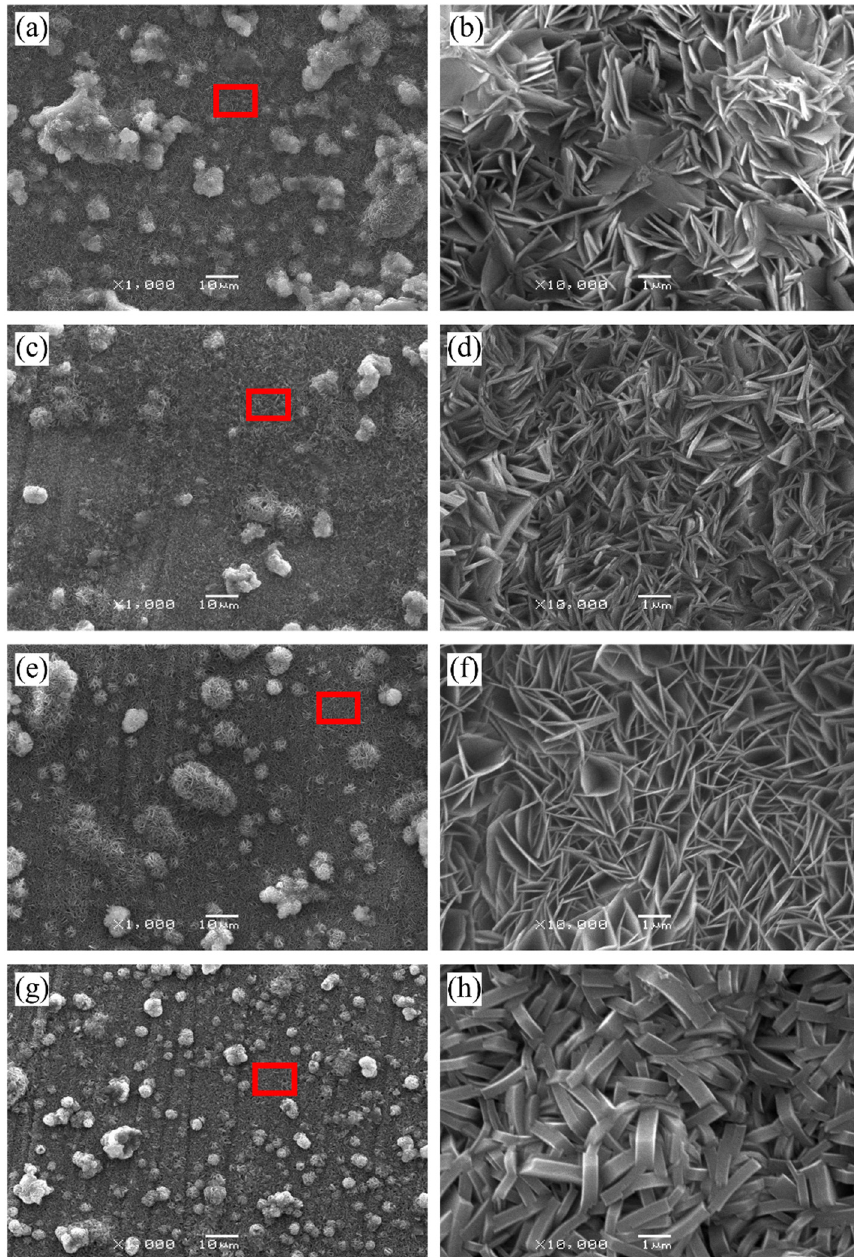
Figure 3. SEM images of different samples: ( a , b ) Mg(OH) 2 , ( c , d ) 6 h, ( e , f ) 12 h, ( g , h ) 24 h. Table 1. EDS results on different samples.